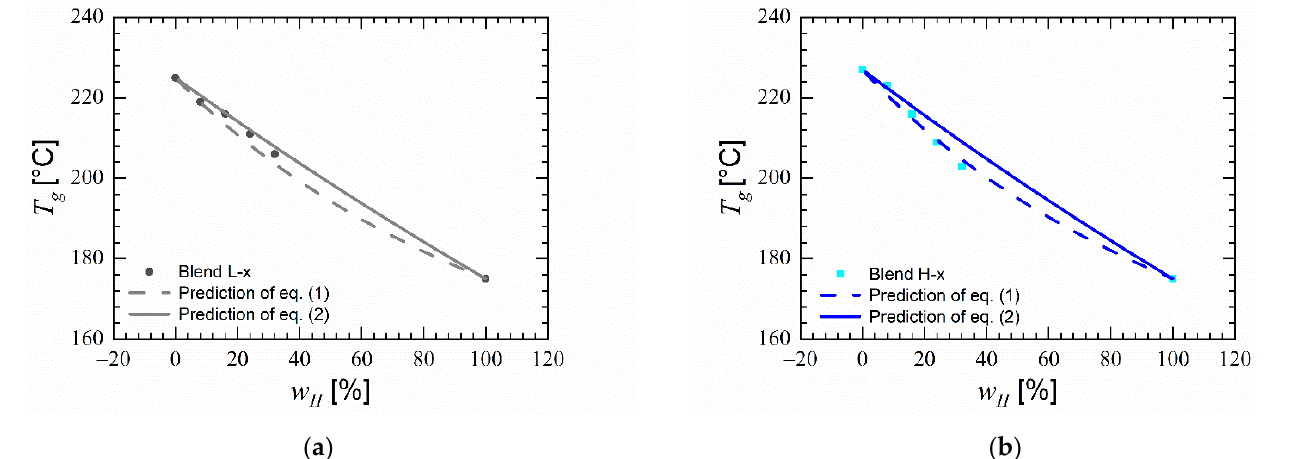
Figure 3. Glass transition temperature versus weight concentration of PVP in blends and predictions of Equations (1) and (2) based on glass transition temperatures of homopolymers; ( a ) Blends with PESU E 2010 (L-x) ( b ) Blends with PESU E 3020 P (H-x).